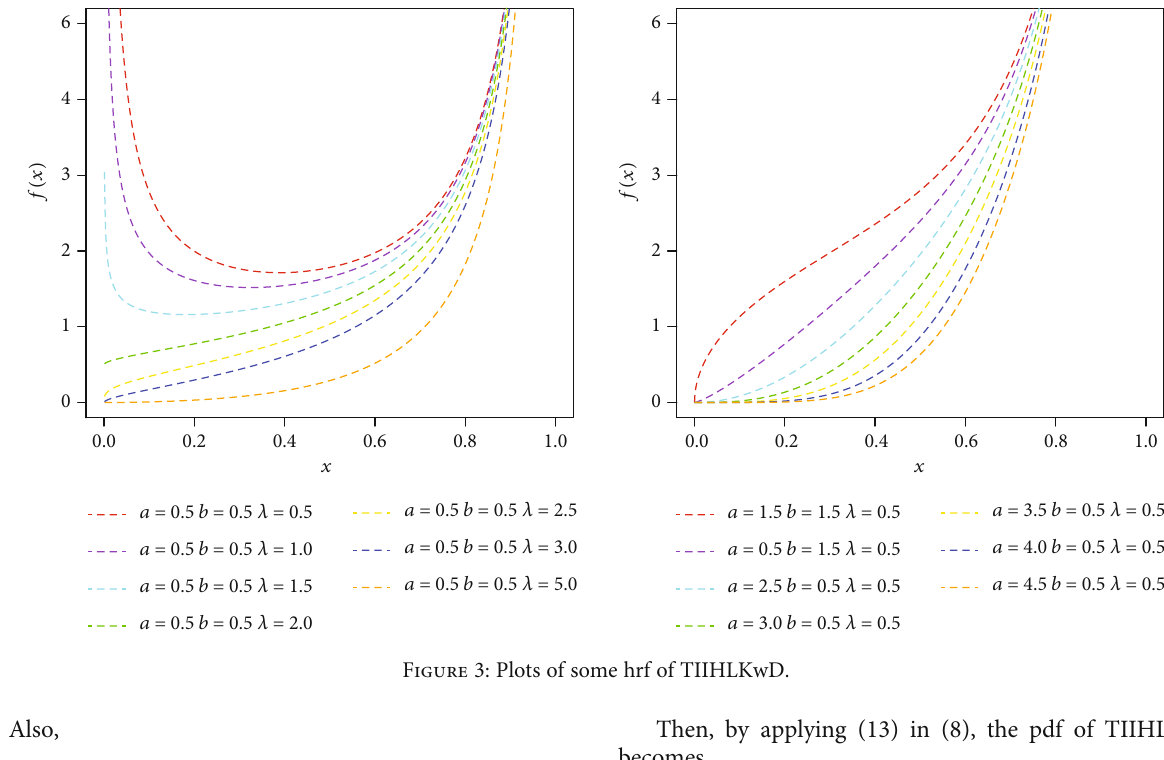
Figure 3: Plots of some hrf of